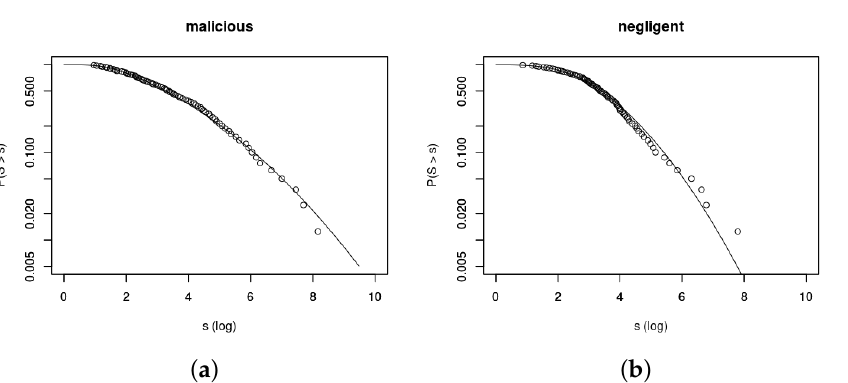
Figure 4. The empirical distribution function of the (logarithm of the) number of breached records (circles) compared to the estimated distribution function (black line) for ( a ) malicious and ( b ) negligent breach types, respectively. Data for all but MED type companies as reported in the PRC dataset in the time period 2010–2019.